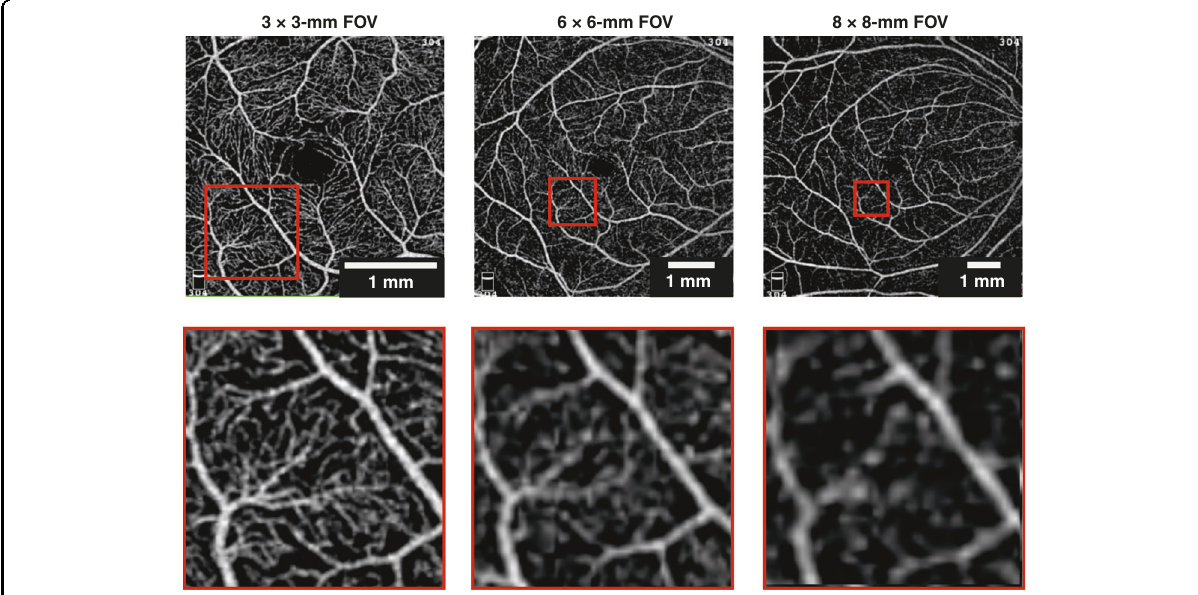
Fig. 6 Comparison of OCTA images versus FOV and sampling density. All images acquired with AngioVue. First row shows original images. Second row shows zoomed images of the same 1 × 1-mm region of interest with transverse scanning density (left to right) of 2, 1, and 0.85, respectively, strongly suggesting only the images in the fi rst column are of suf fi cient quality for quanti fi cation